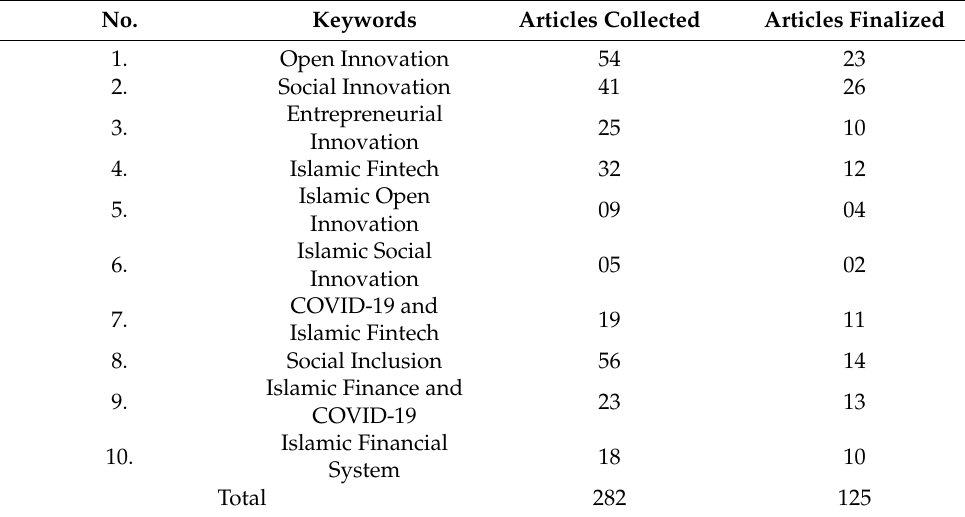
Table 1. Final Articles Chosen for Content Analysis.